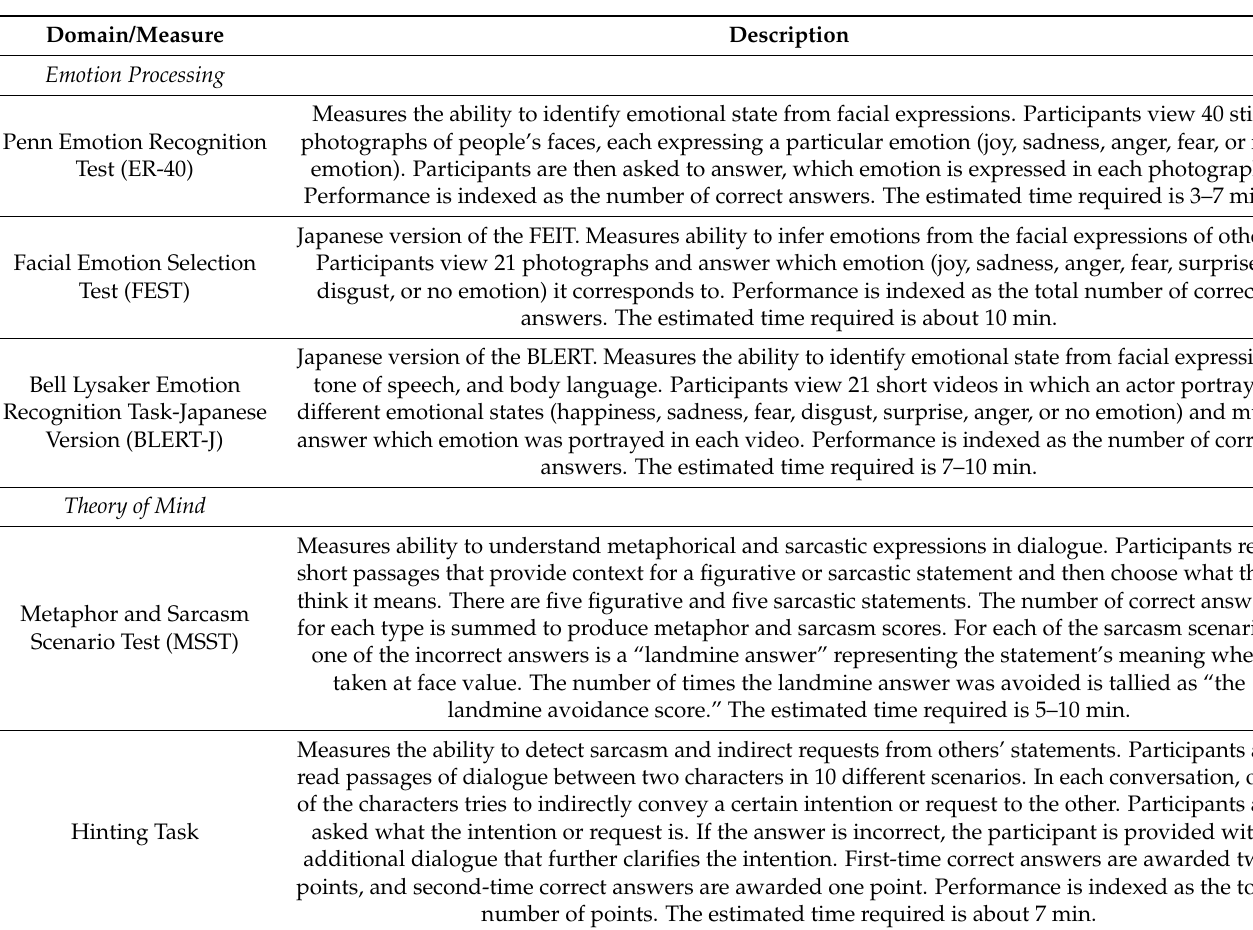
Table 3. List and descriptions of the final